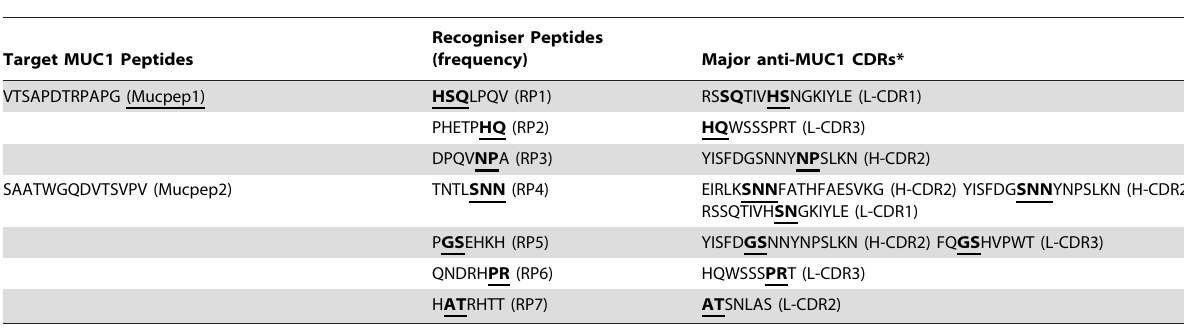
Table 1. MUC1 peptides and their corresponding recogniser peptides.